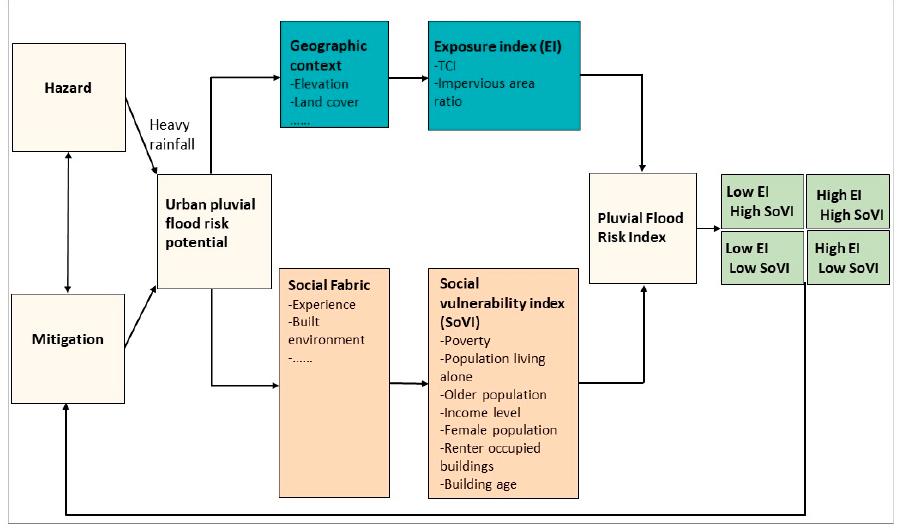
Figure 2. Urban pluvial flood risk assessment framework.